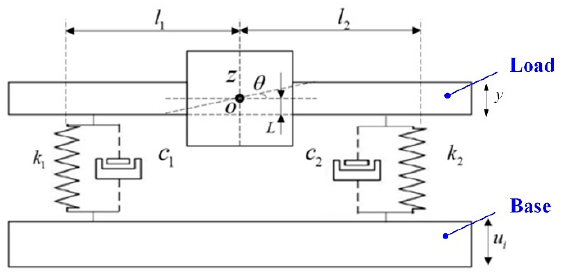
Figure 4. Schematic diagram of freedom model for the 2D vibration isolation system.